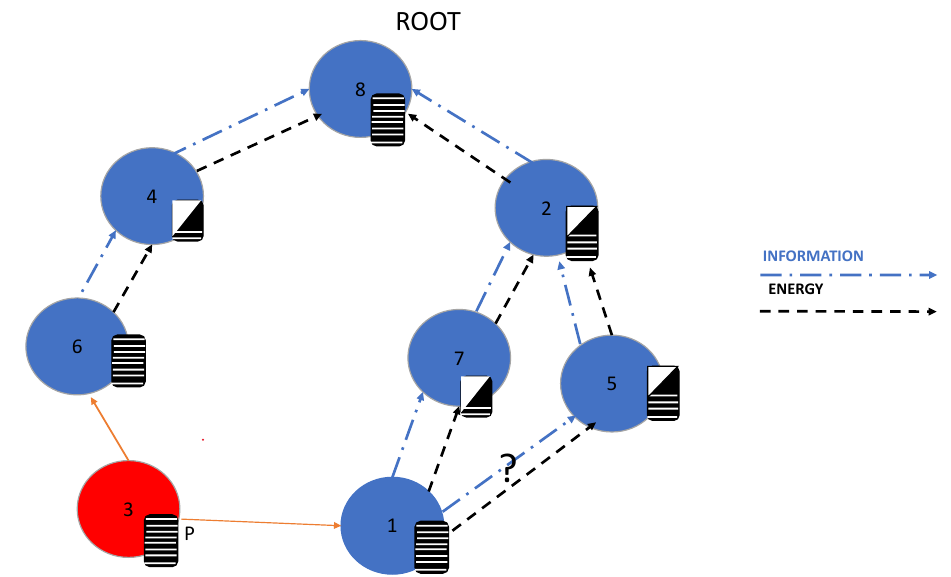
Figure 2. Low-Power and Lossy Network (LLN) network